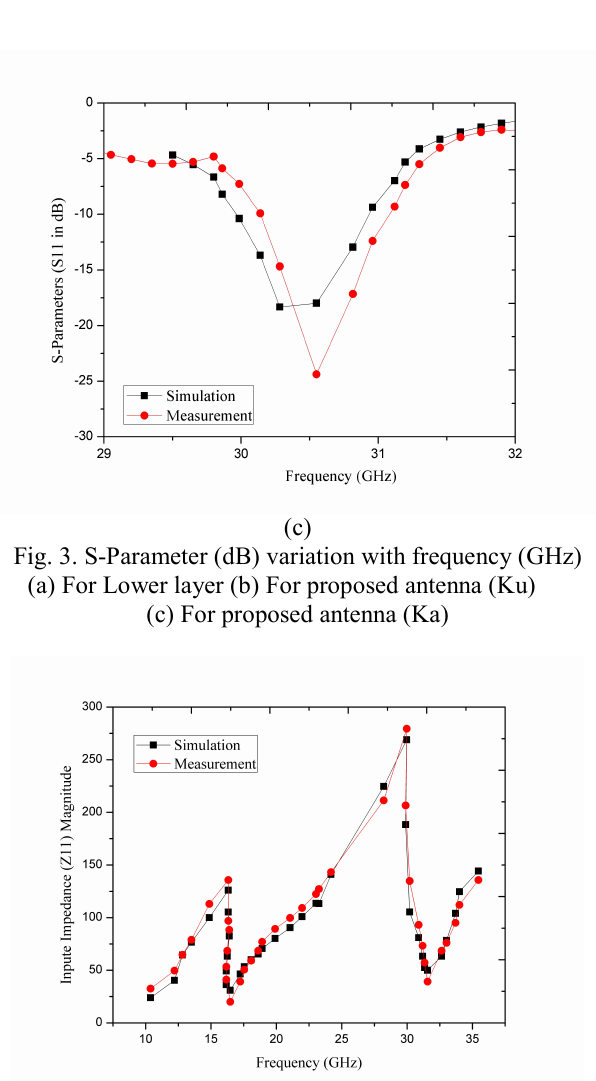
Fig. 4. Input Impedance (magnitude) for proposed antenna Fig. 5 is showing the surface current distribution for the proposed antenna design. Fig. 5(a) shows the distribution at lower resonant frequency and 5(b) shows the distribution at higher resonant frequency. From the figures, we can clearly see the high current density areas at the two frequencies.